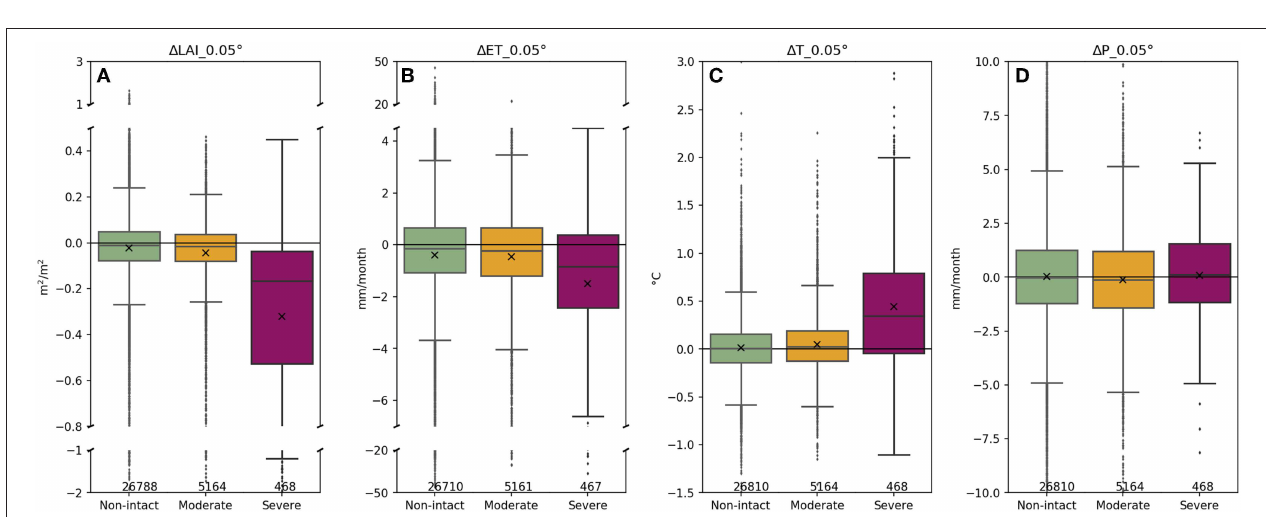
FIGURE 3 | Changes in annual mean 0.05 ◦ remotely-sensed leaf area index (A) , evapotranspiration (B) , daytime land surface temperature (C) and precipitation (D) , averaged over pixels in each disturbance category, and expressed relative to the changes observed over neighboring intact forest, for the period 2001–2013. The boxes in each panel represent the quartiles of each dataset, mean values are marked with an “x,” and values along the lower axis indicate the number of data